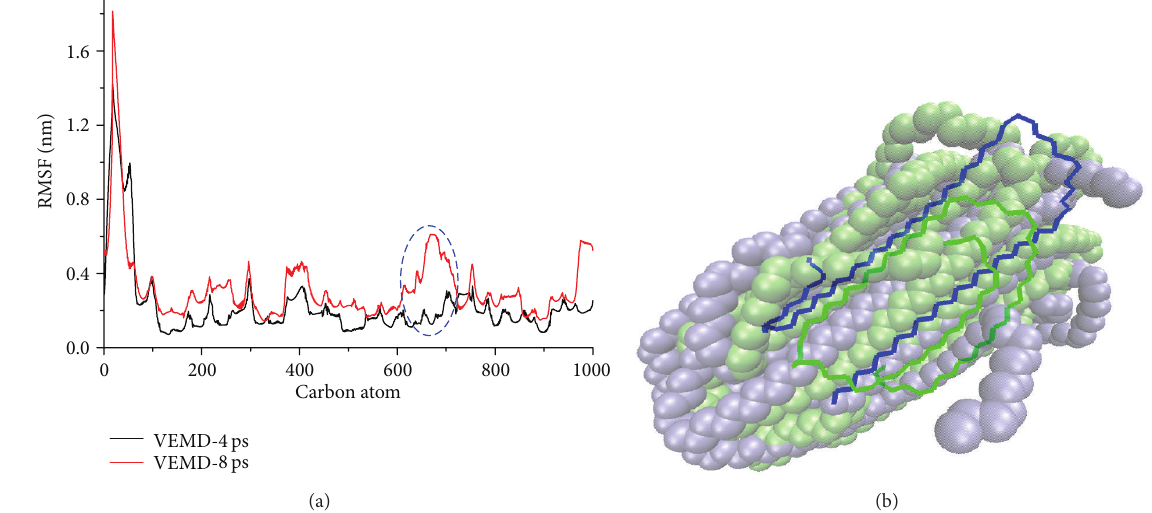
Figure 8: The RMSF values of carbon atoms of the polyethylene molecule (a) and the overlaid final structures (b) of the VEMD simulations with 4 (shown in green in (b)) and 8ps (shown in blue in (b)) vibration periods.